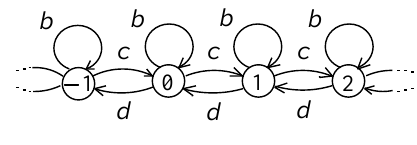
Fig. 3: Random walk on the